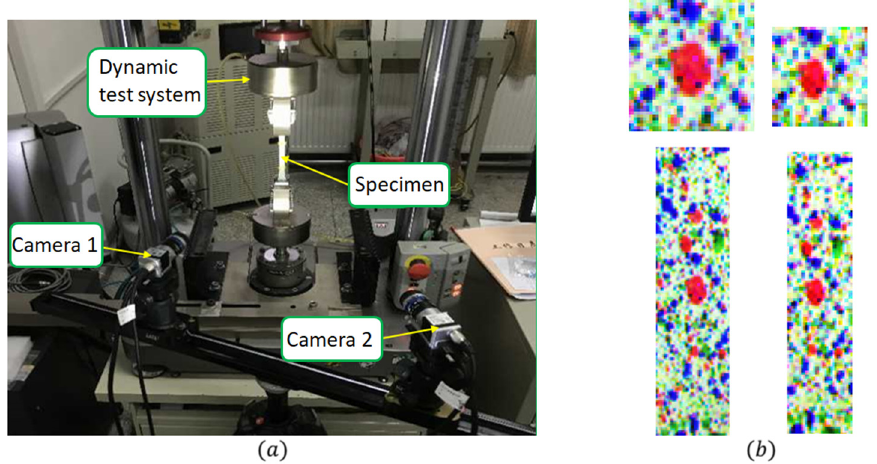
Figure 9. The physical diagram of the uniaxial tension experiment based on the 3D-DIC measurement device; ( a ) the physical map of the experiment; ( b ) the speckle images of different scales taken by the two cameras.